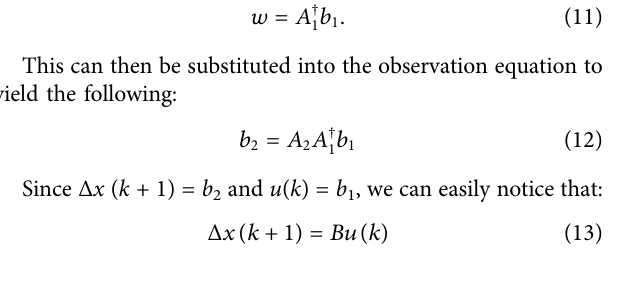
Frontiers in Robotics and AI |